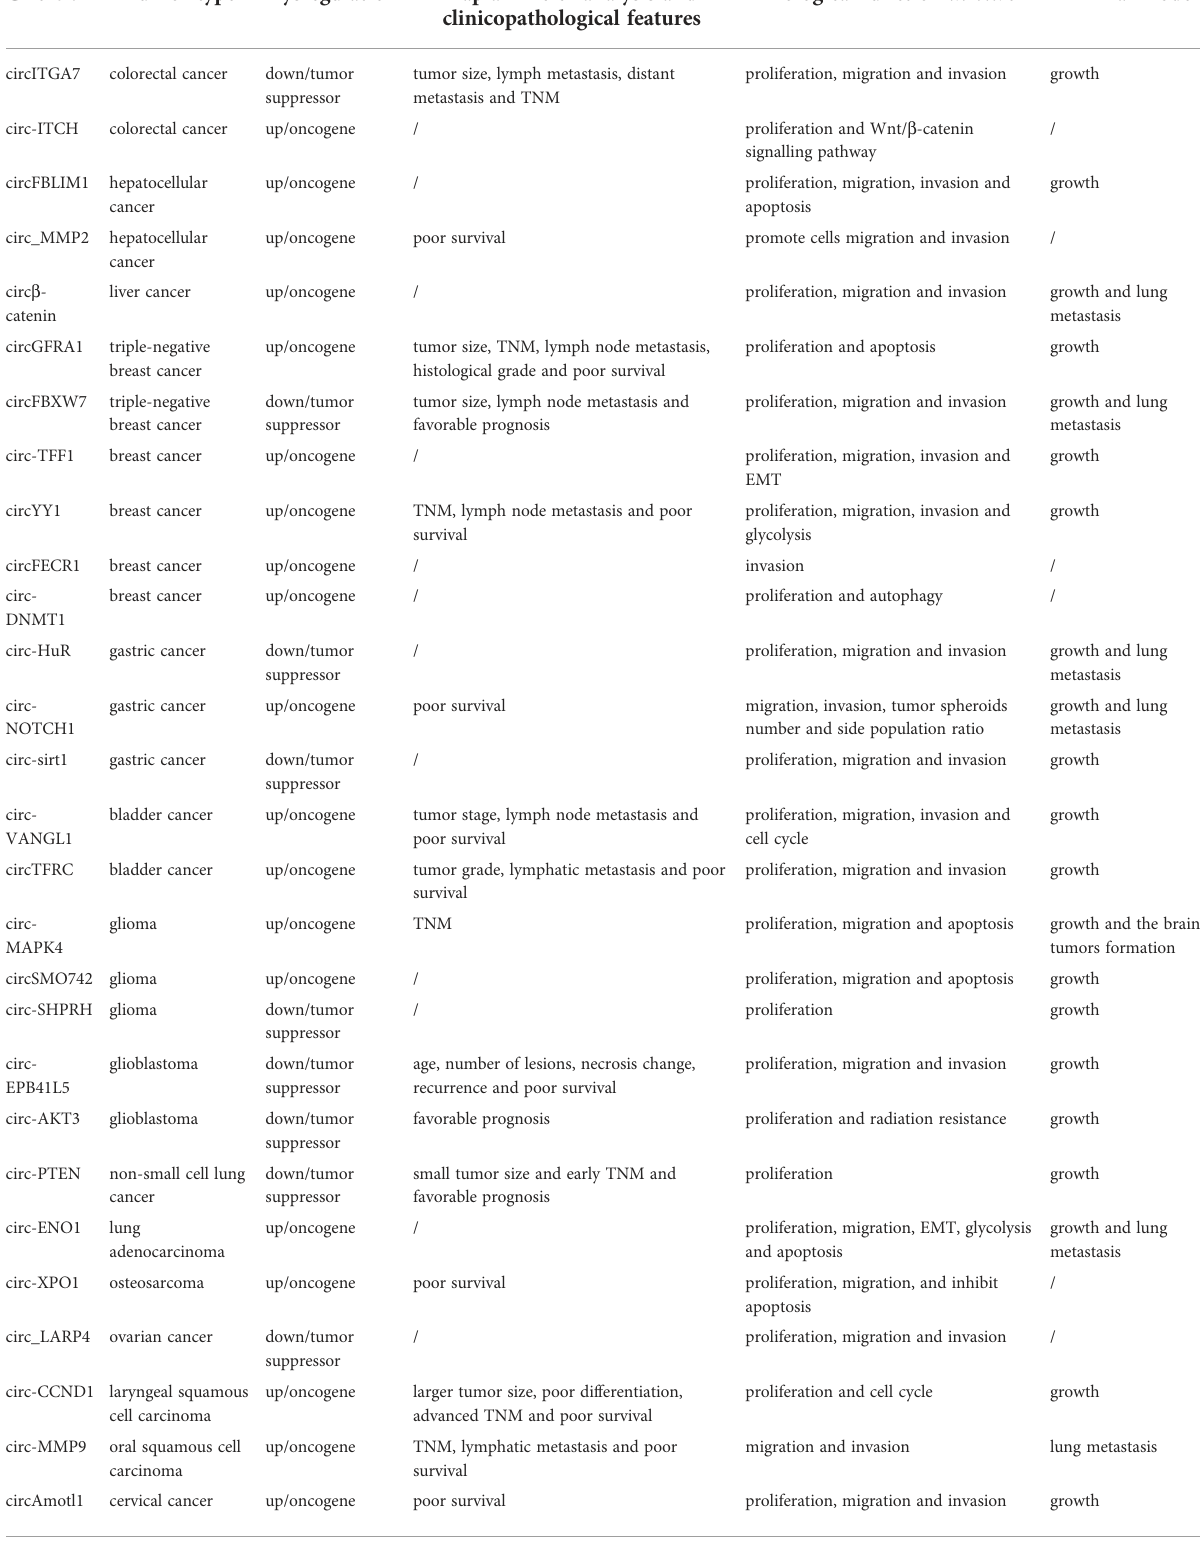
TABLE 2 The role of parental genes encoded circRNAs in malignant